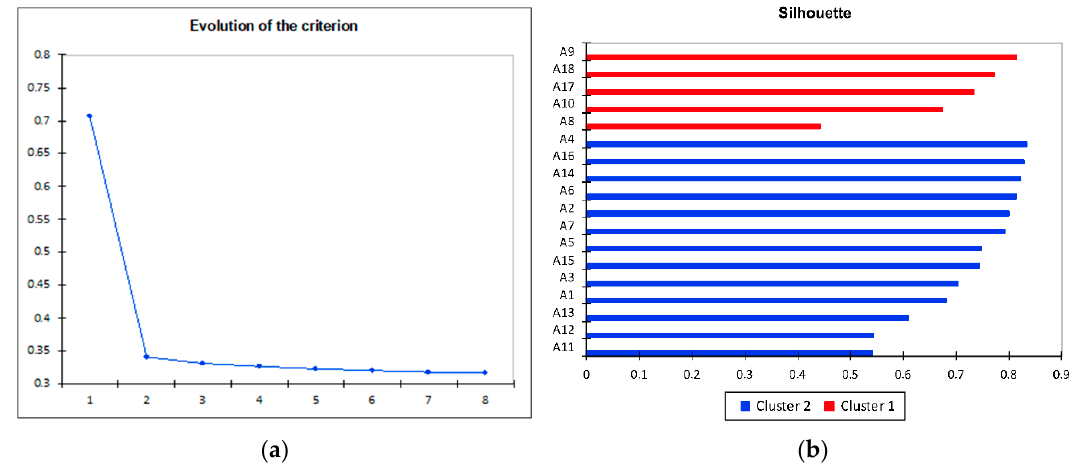
Figure 7. ( a ) Evolution of the clustering criterion. ( b ) Silhouettes of clusters.